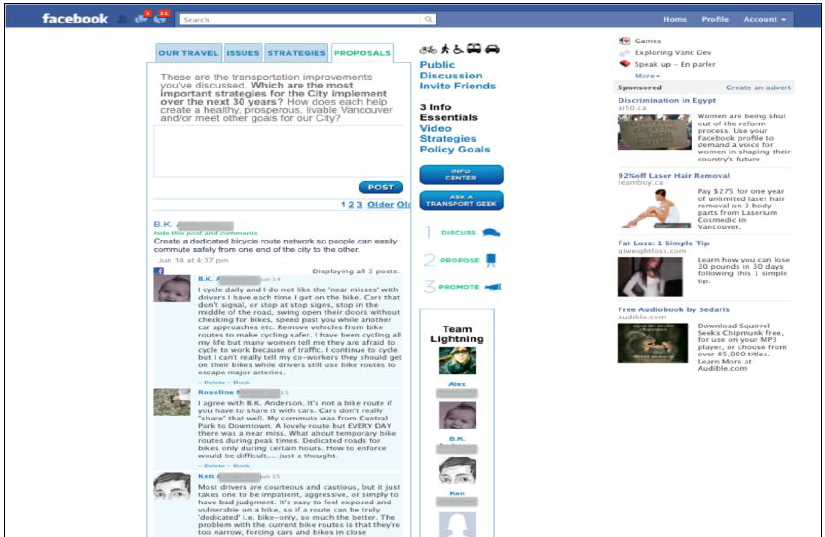
Figure 2: An EVTF discussion